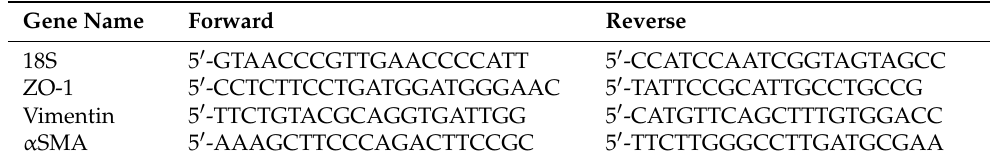
Table 1. Primer sequences for quantitative real-time